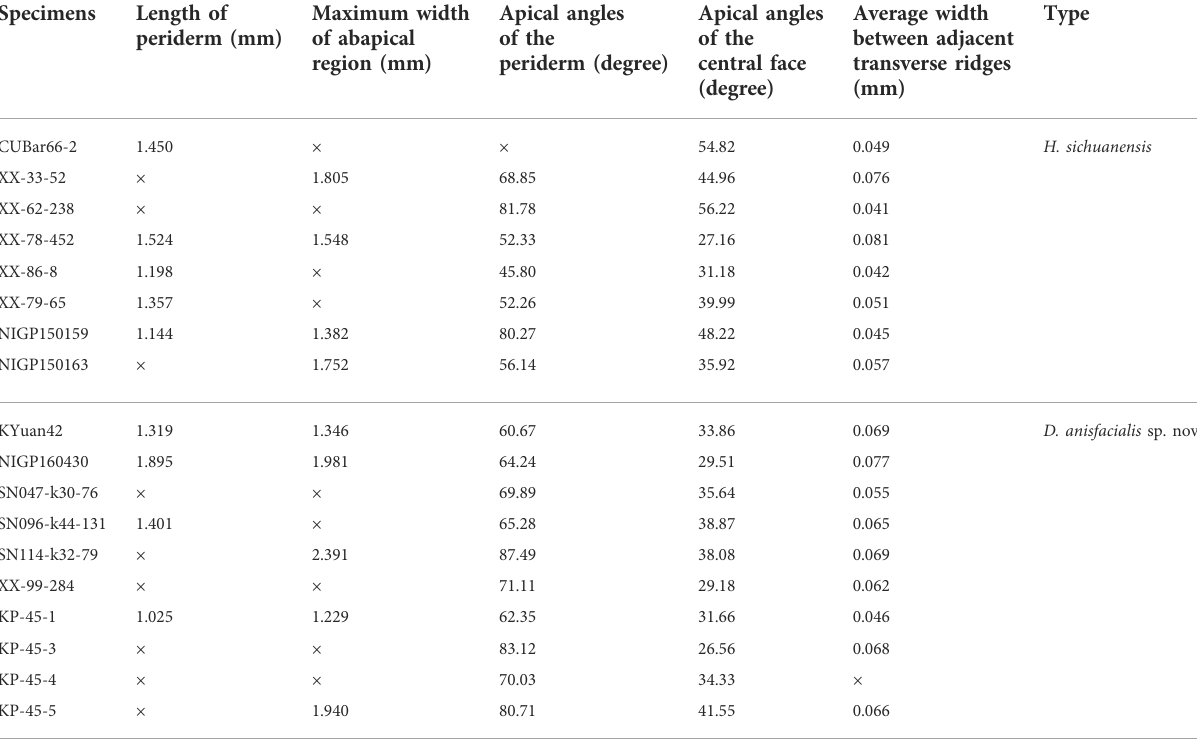
TABLE 1 Measurements of eight well-preserved Hexaconularia sichuanensis and 10 well-preserved Decimoconularia anisfacialis sp. nov